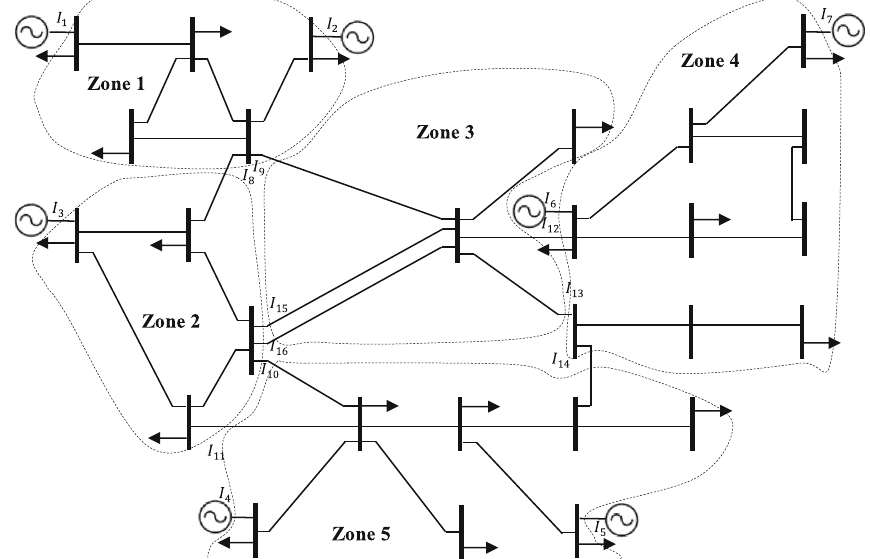
Fig. 4 Illustrating zone partition for fault zone identification